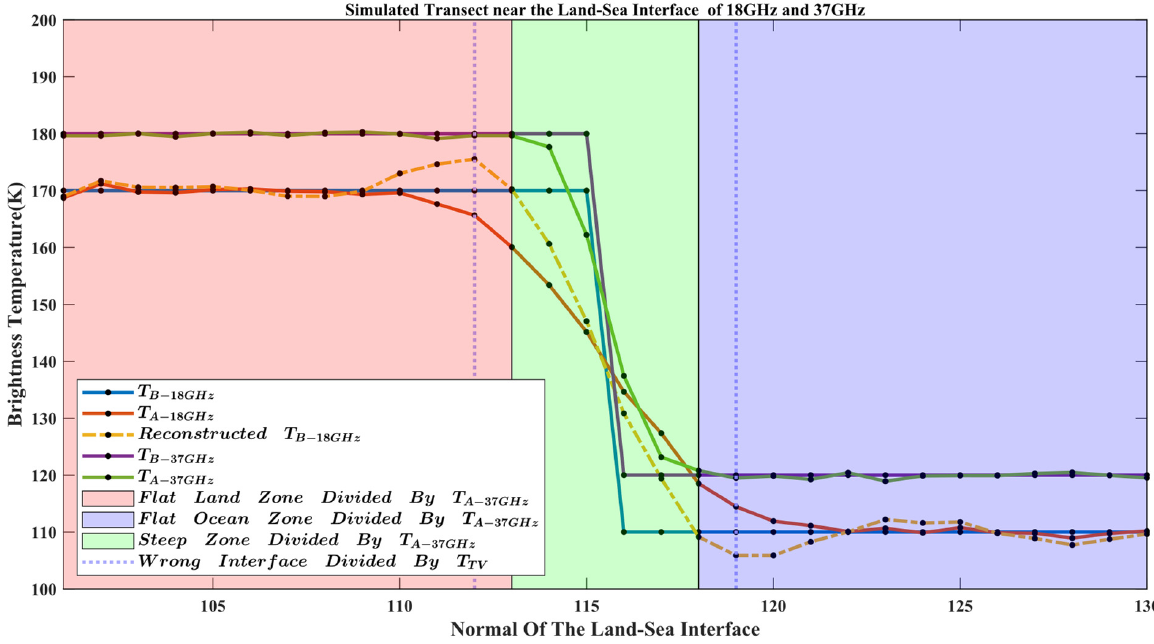
Figure 7. Simulated performance of 18 and 37 GHz near the transition zone with abrupt discontinu- ity.